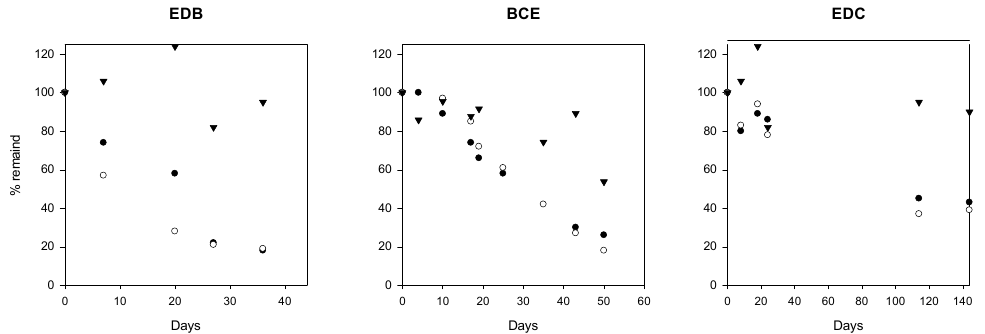
Figure 5. Degradation of Dibromoethane (EDB), 1-bromo-1-chloroethane (BCE) and 1,2-dichloroethane (EDC) by fresh RH49 groundwater microbial community. Open and filled circles represent individual sample bottles and filled triangles represent autoclaved control bottles.